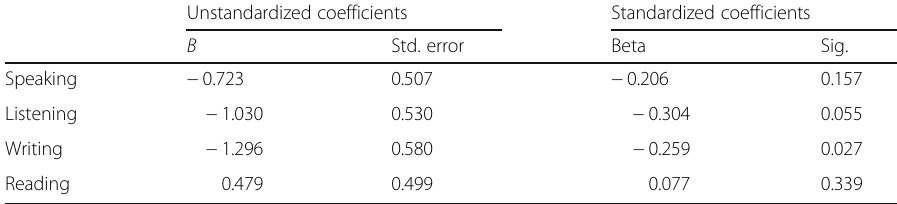
Table 5 The results of multiple regression analysis for the language proficiency subskills and emotional